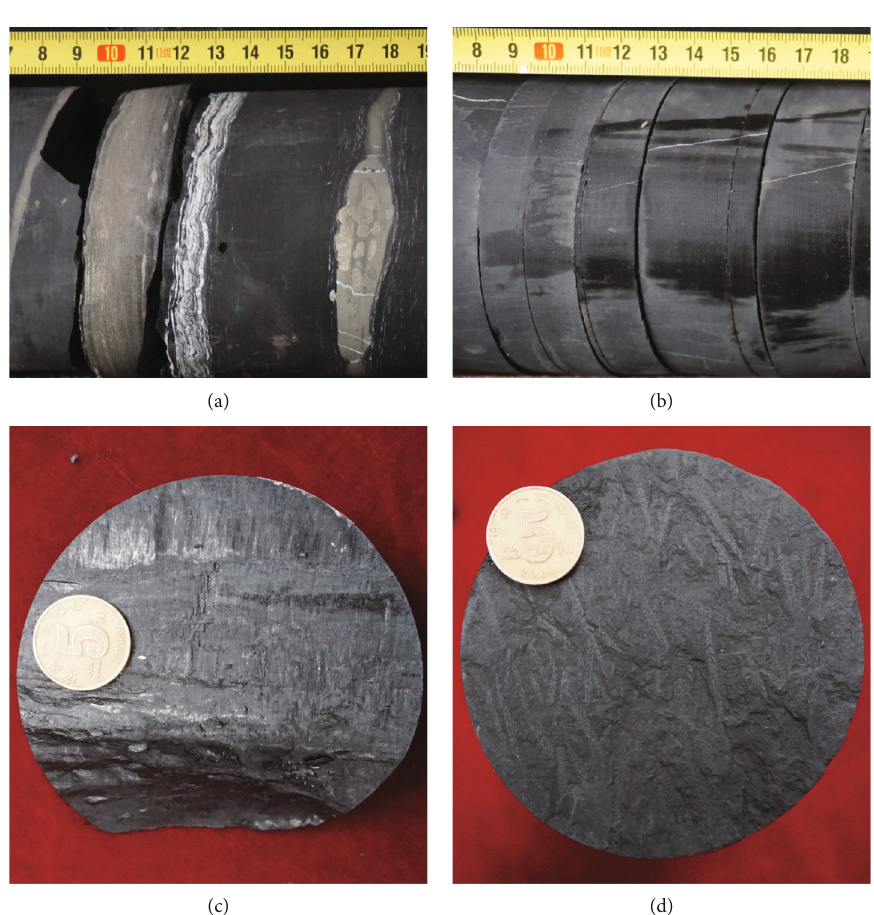
Figure 2: Photograph of the core: (a) pyrite; (b) horizontal bedding; (c) carbonaceous shale; (d)